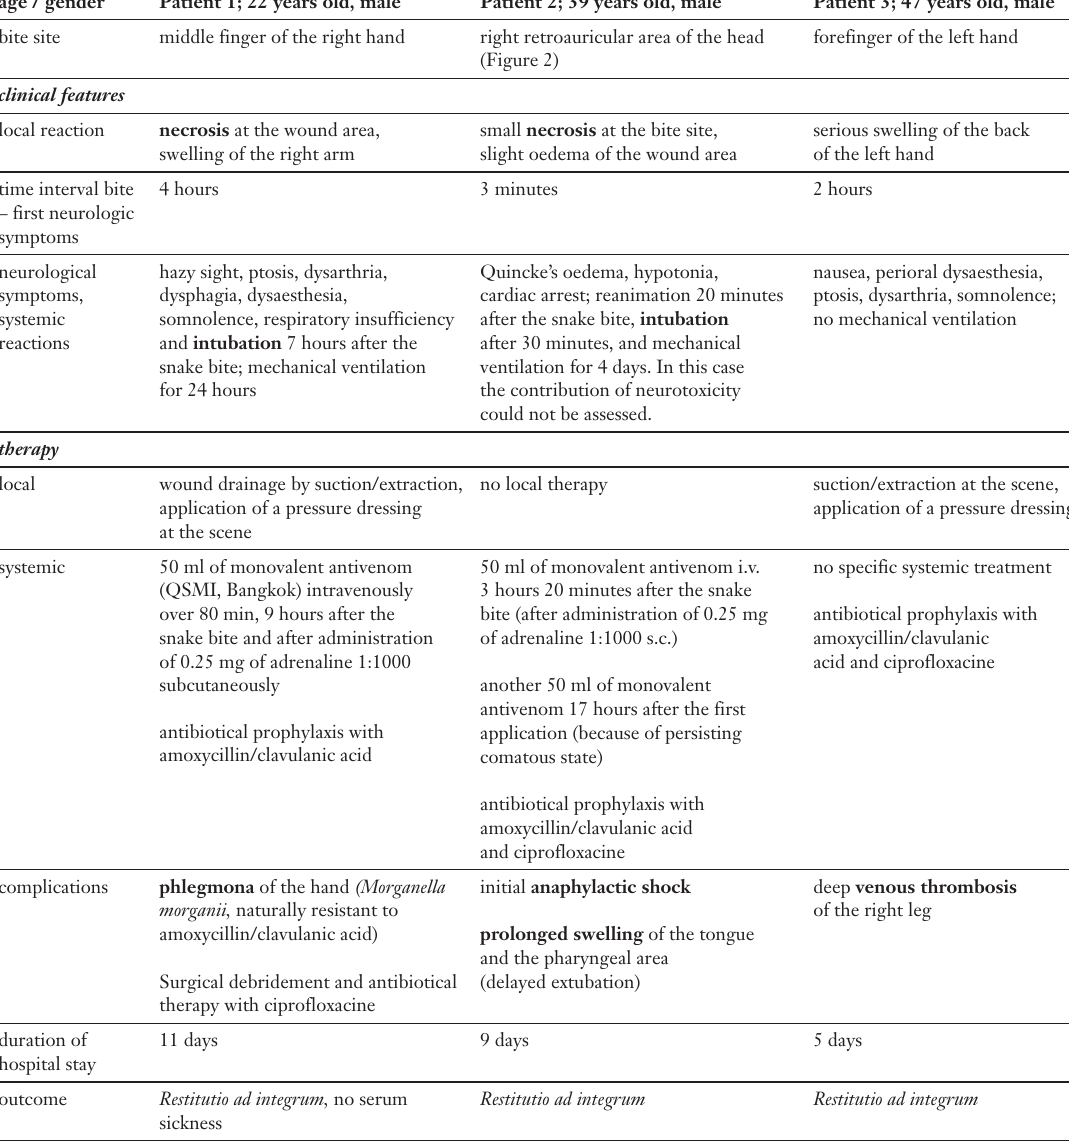
Features of the three cases bitten by Thai cobra Naja